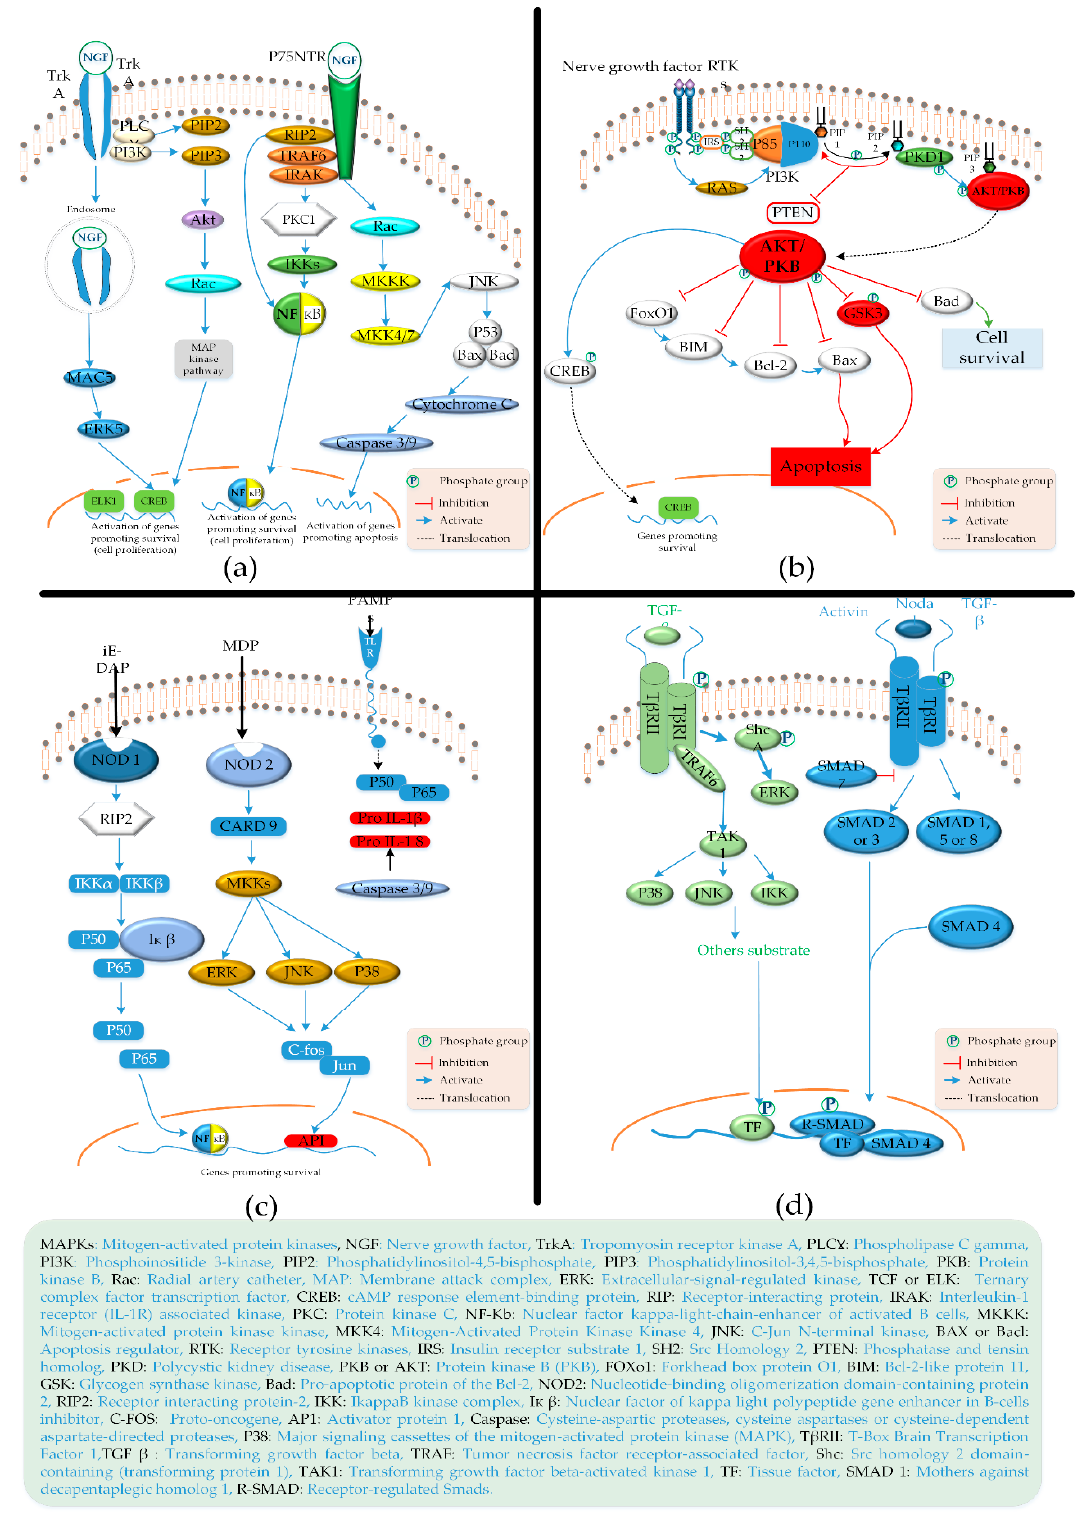
Figure 7. Signaling pathways and corresponding receptors: ( a ) P75 neurotrophin receptor (p75NTR) activation pathway, ( b ) PI3K/AKT is an intracellular signal pathway, ( c ) pattern recognition receptors (NOD1, NOD2), and ( d ) transforming growth factors (TGF- β ) in SMAD signaling pathway.